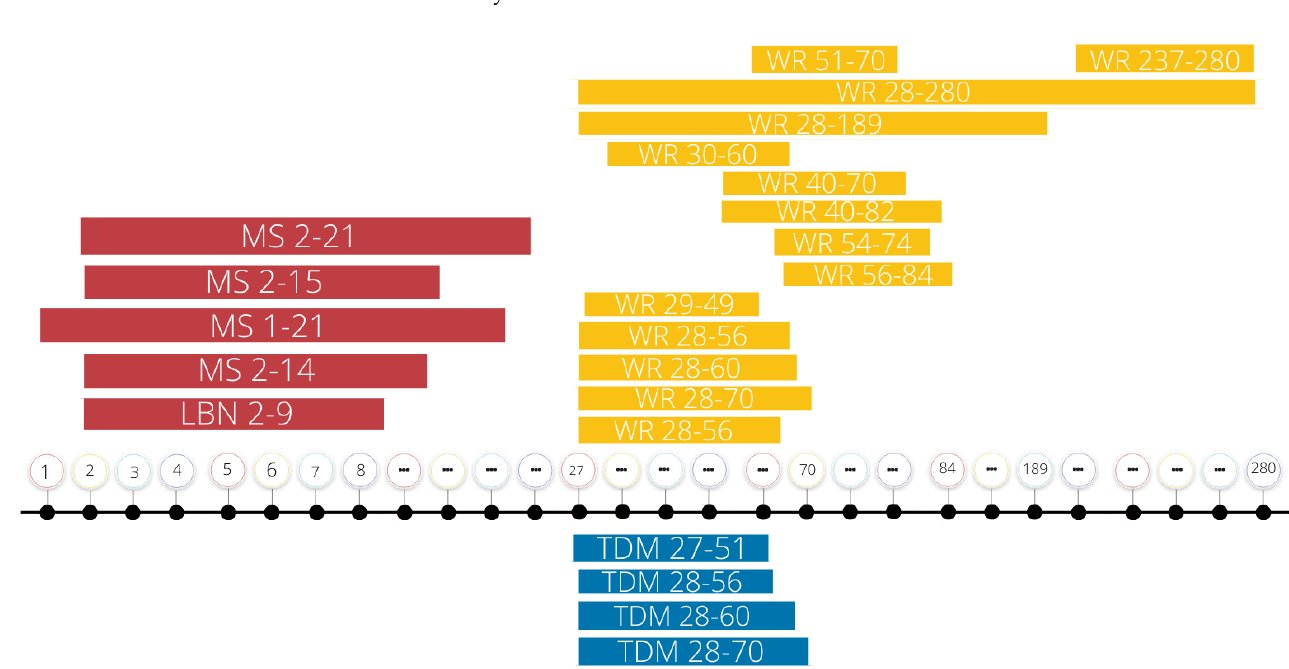
Figure 1. Summary of current ELS and exercise intervention protocols. This summary figure represents the days, recorded in postnatal days, of early life stress exposure and exercise interventions recounted in this review. Note the variability in experimental parameters. MS, maternal separation; LBN, limited bedding and nesting; WR, wheel running; TDM, treadmill; “…”, breaks in the timeline.